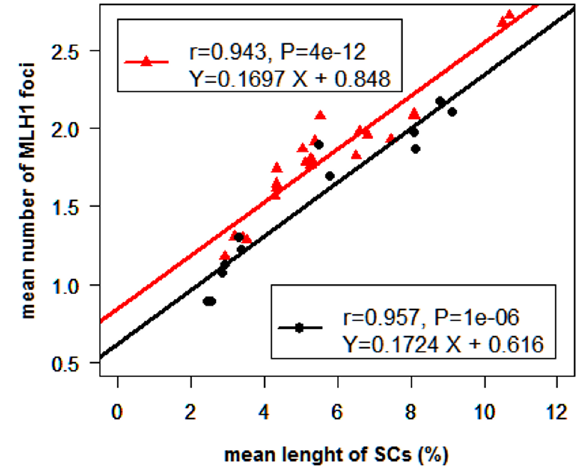
Figure 3. Relationship between the average number of MLH1 foci and the average absolute SC length for the 2 types of autosomes: non-acrocentrics (SSC1 to SSC12) in red and acrocentrics (SSC13 to SSC18) in black.